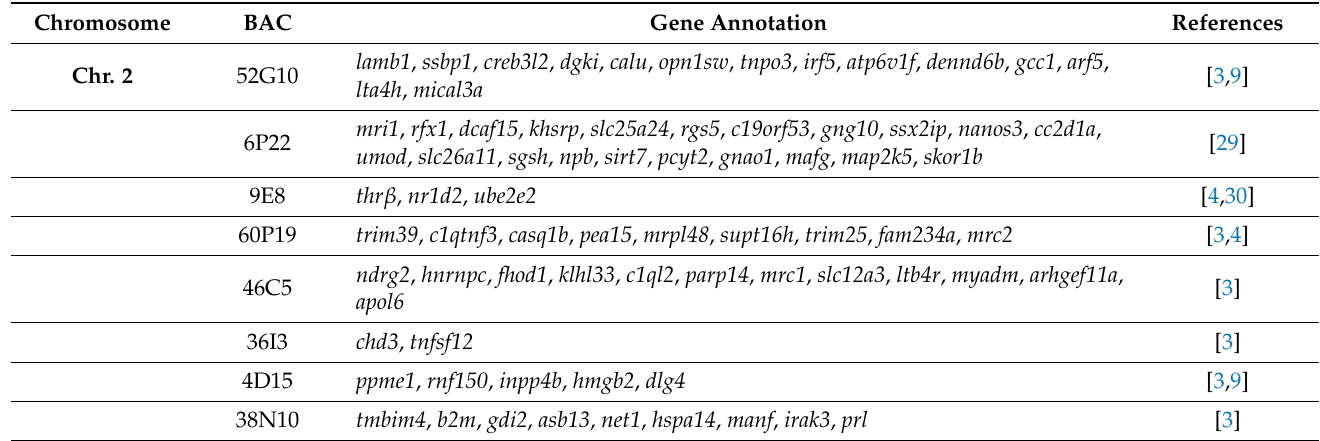
Table 1. BAC clones analyzed in this study and gene annotation. Chromosome BAC Gene